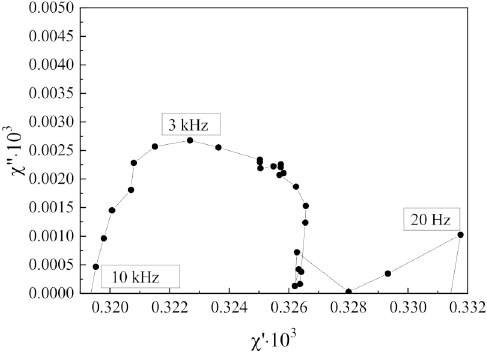
Figure 7. Argand diagram plotted at T = 4 K for the AC susceptibility of the composite with the ytterbium titanate particles.